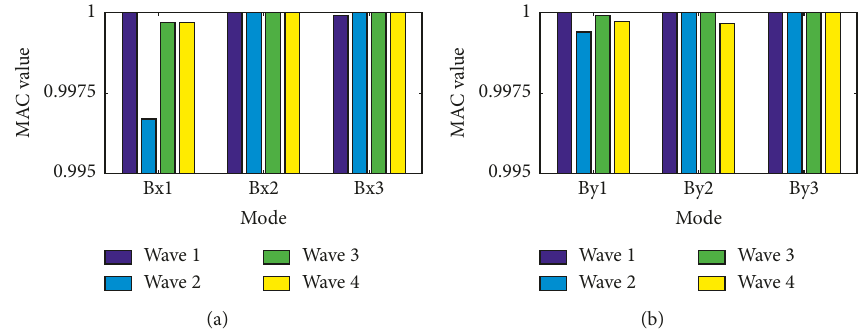
Figure 21: MAC values of mode shapes of Waves 1–4 relative to eigenvalue analysis. (a) Along-wave bending mode. (b) Across-wave bending